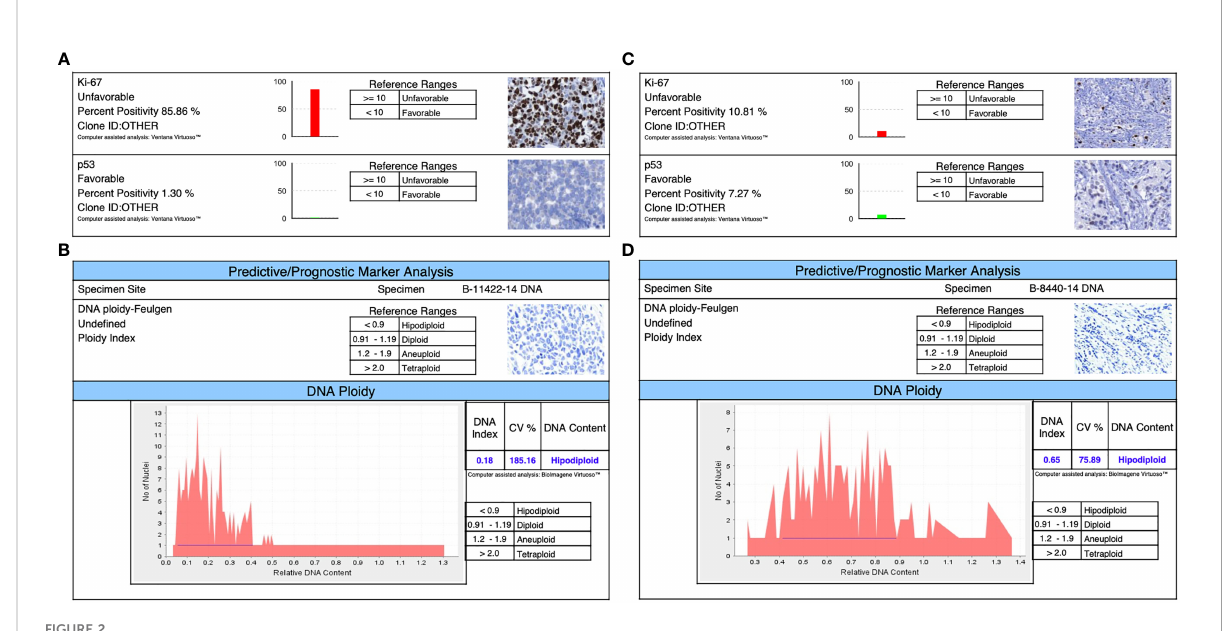
FIGURE 2 Immunophenotyping shows in both triple-negative lines: (A) for DSG -BC1, a Ki67 of 85.85% and a TP53 of 1.3%. (B) The ploidy of DSG-BC1 revealed a hypodiploid DNA content. (C) For DSG -BC2, a Ki67 of 10.81% and a TP53 of 7.27%. (D) The ploidy of DSG-BC2 revealed a hypodiploid DNA